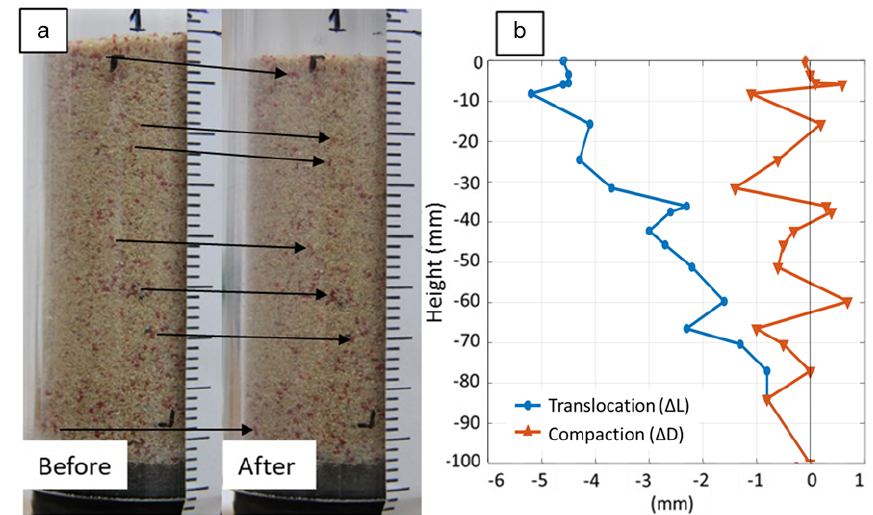
Figure 5. (a) Photos of the examined sand column “Before” and “After” compaction. Black arrows exemplify the vertical transition, due to compaction, of selected colored grains; (b) measured changes in grain translocation and compaction along the sand column.